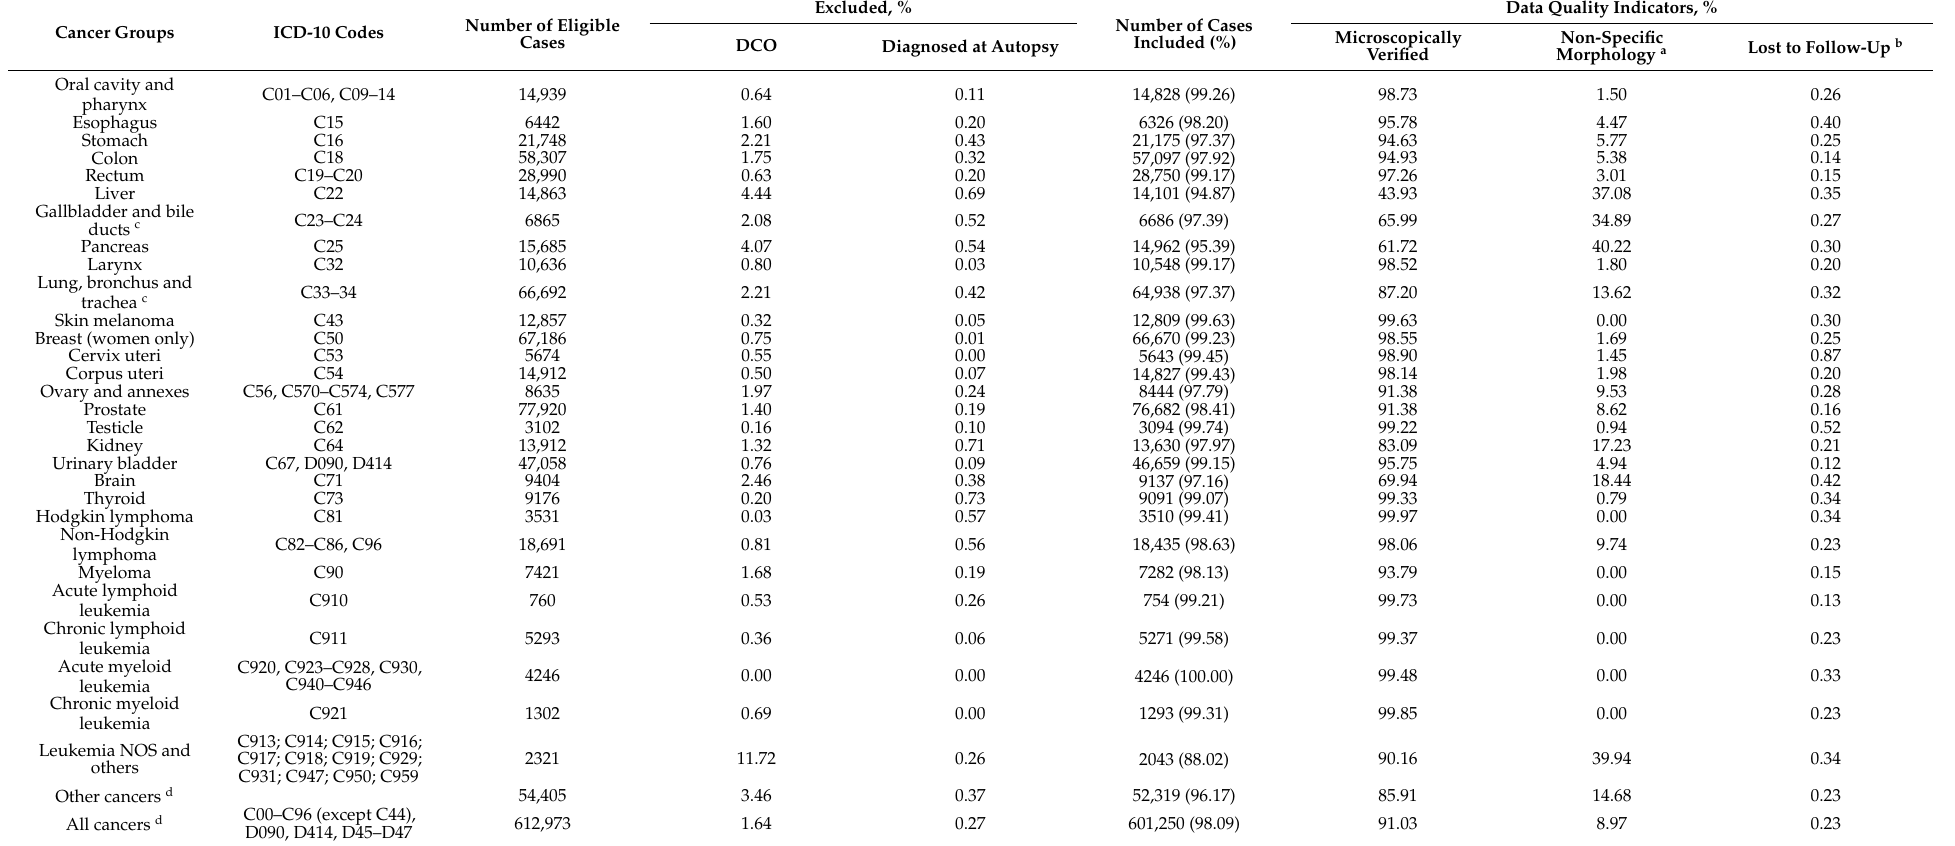
Table 1. Cancer groups, number of cases included and data quality indicators,